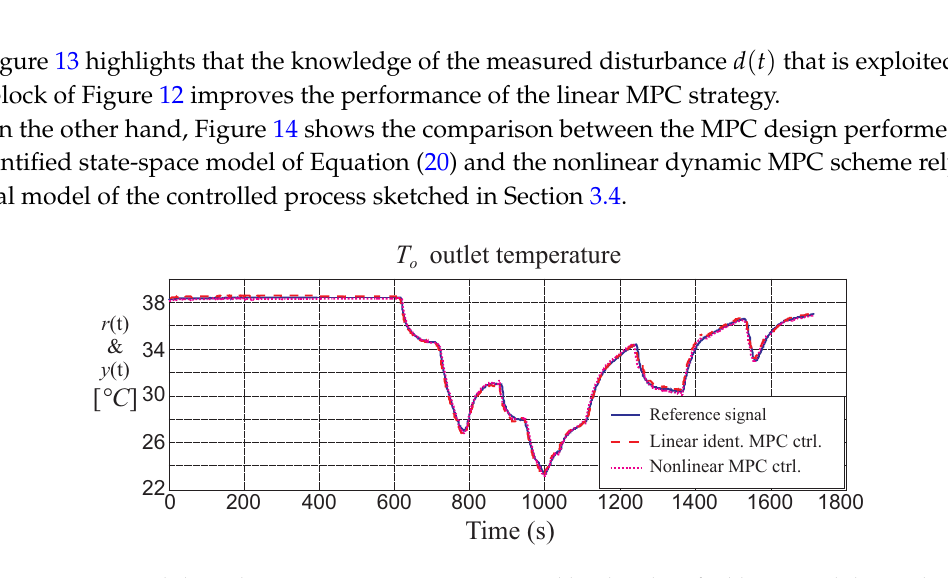
Figure 14. TU module outlet air temperature compensated by the identified linear and the nonlinear MPC solutions.